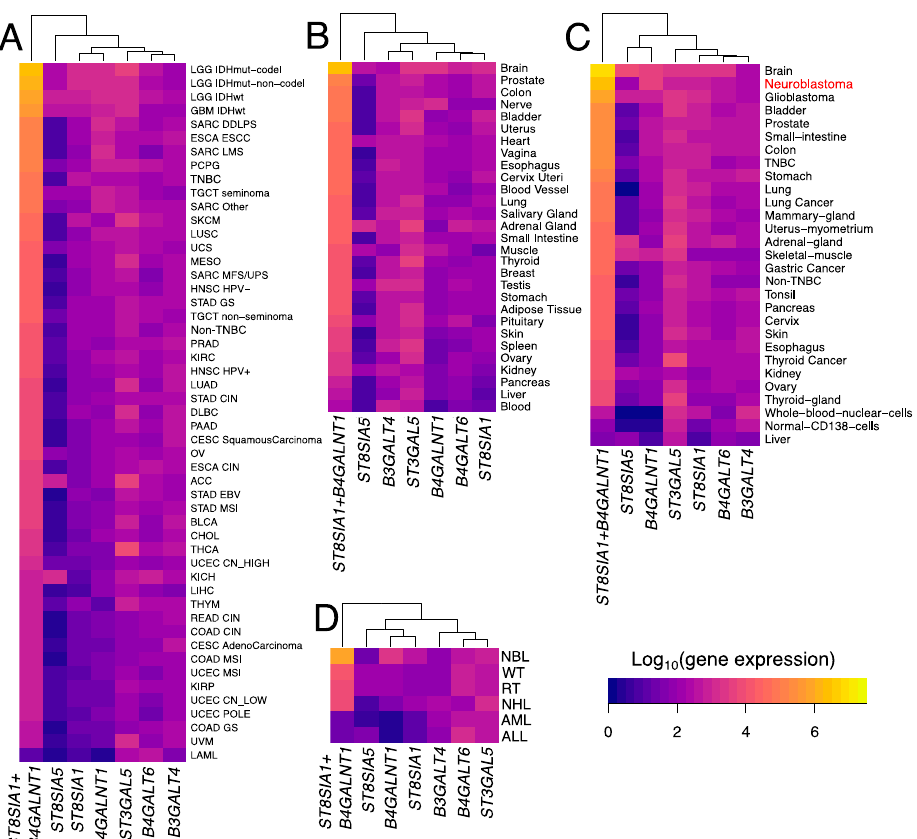
Figure 4. Heatmaps showing gene expression of ganglioside biosynthesis enzymes and the ‘ ST8SIA1 + B4GALNT1 ’ gene signature score for cancer and healthy human tissues. ( A ) TCGA database profiles, ( B ) GTEx database profiles, ( C ) ANTE database profiles and compatible cancer samples, ( D ) TARGET database profiles. Color scale indicates log10-transformed DESeq2-normalized gene expression values. Sample types in each panel are sorted in descendent order by 2-gene gene signature score. TCGA disease codes and abbreviations: LAML: acute myeloid leukemia; ACC: adrenocortical carcinoma; TNBC: triple negative breast cancer; Non-TNBC: non-triple negative breast cancer; CESC: cervical squamous cell carcinoma and endocervical adenocarcinoma; KICH: kidney chromophobe; KIRC: kidney renal clear cell carcinoma; COAD: colorectal adenocarcinoma; SKCM: skin cutaneous melanoma; DLBC: lymphoid neoplasm di ff use large B-cell lymphoma; GBM: glioblastoma multiforme; HNSC: head and neck squamous cell carcinoma; LIHC: liver hepatocellular carcinoma; LGG: